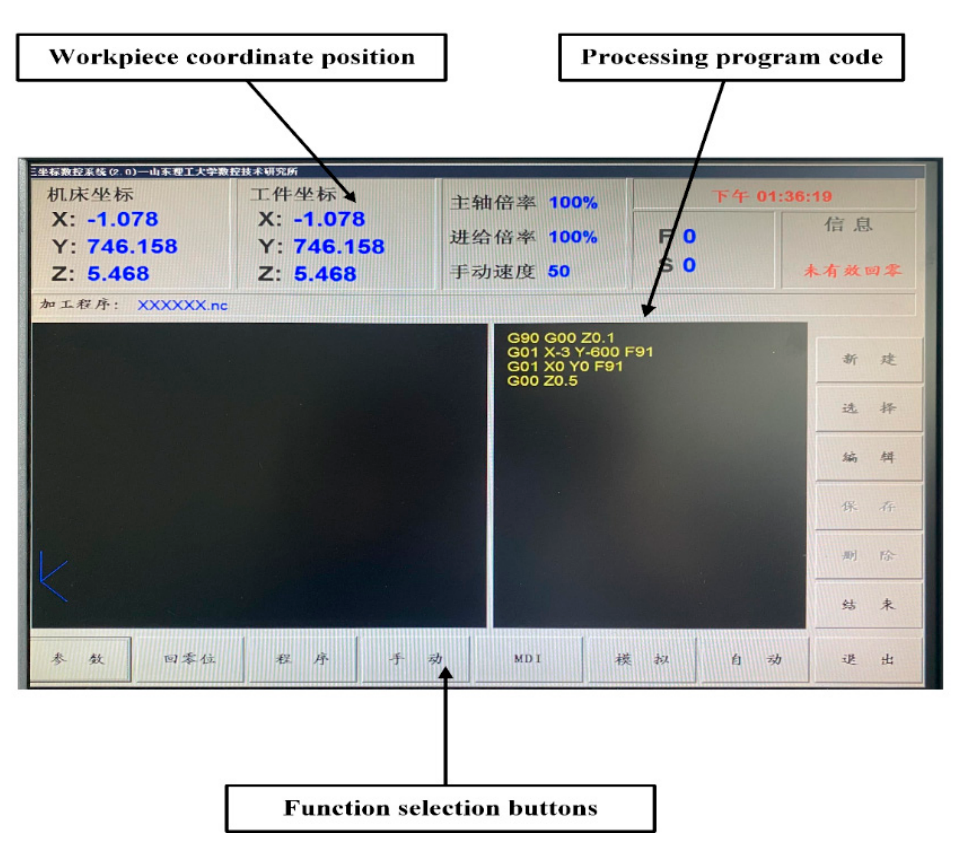
Figure 2. Interface of the control system for ultrasonic high-frequency percussion fabrication of ultra-fine and ultra-long copper tube electrode equipment. Table 1. Performance of ultrasonic percussion processing experimental equipment for copper tube electrodes.